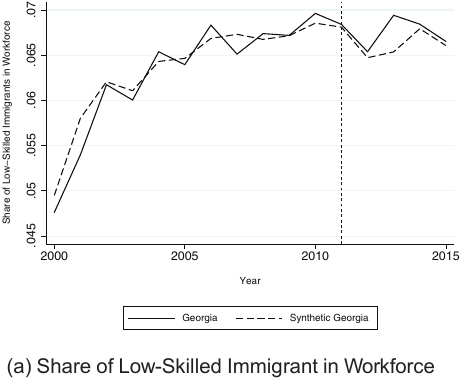
Figure A4 Georgia universal e-verify and share of low-skilled immigrants in workforce